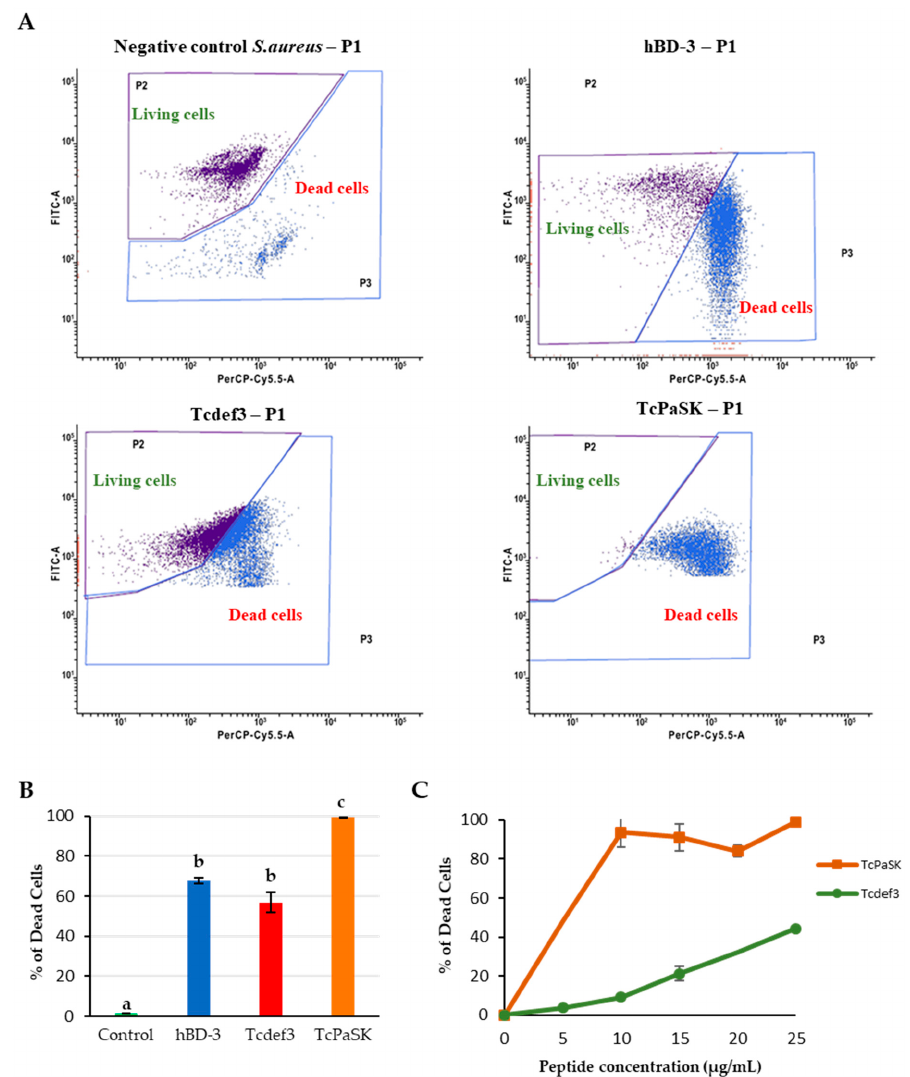
Figure 2. Antibacterial activity of hBD-3, Tcdef3 and TcPaSK peptides against S. aureus . ( A ) Flow cytometry dot plots of S. aureus cells non-treated (negative control) and treated with hBD-3 (positive control), Tcdef3 and TcPaSK peptides, stained with SYBR Green (membrane permeable) and propidium iodide (membrane impermeable) dyes. On the ordinate, FICT refers to fluoroscein and indicates the cells that have incorporated SYBR Green. On the abscissa axis, PerCP-Cy5.5-A refers to Peridinin-chlorophyll proteins and corresponds to cells that have taken up propidium iodide. ( B ) Cytotoxicity against S. aureus of 25 μ g/mL hBD-3, Tcdef3 and TcPaSK peptides. Data represent the mean ± SE of three replicates. Bars with different letters indicate statistically significant differences between AMPs (Student’s t -test, p ≤ 0.05). ( C ) Effect of Tcdef3 and TcPaSK peptide concentration on S. aureus cells viability. The results are expressed as the percentages of the total death cells after 1 h incubation time with the peptides. Points are the means ± SE of two replicates.